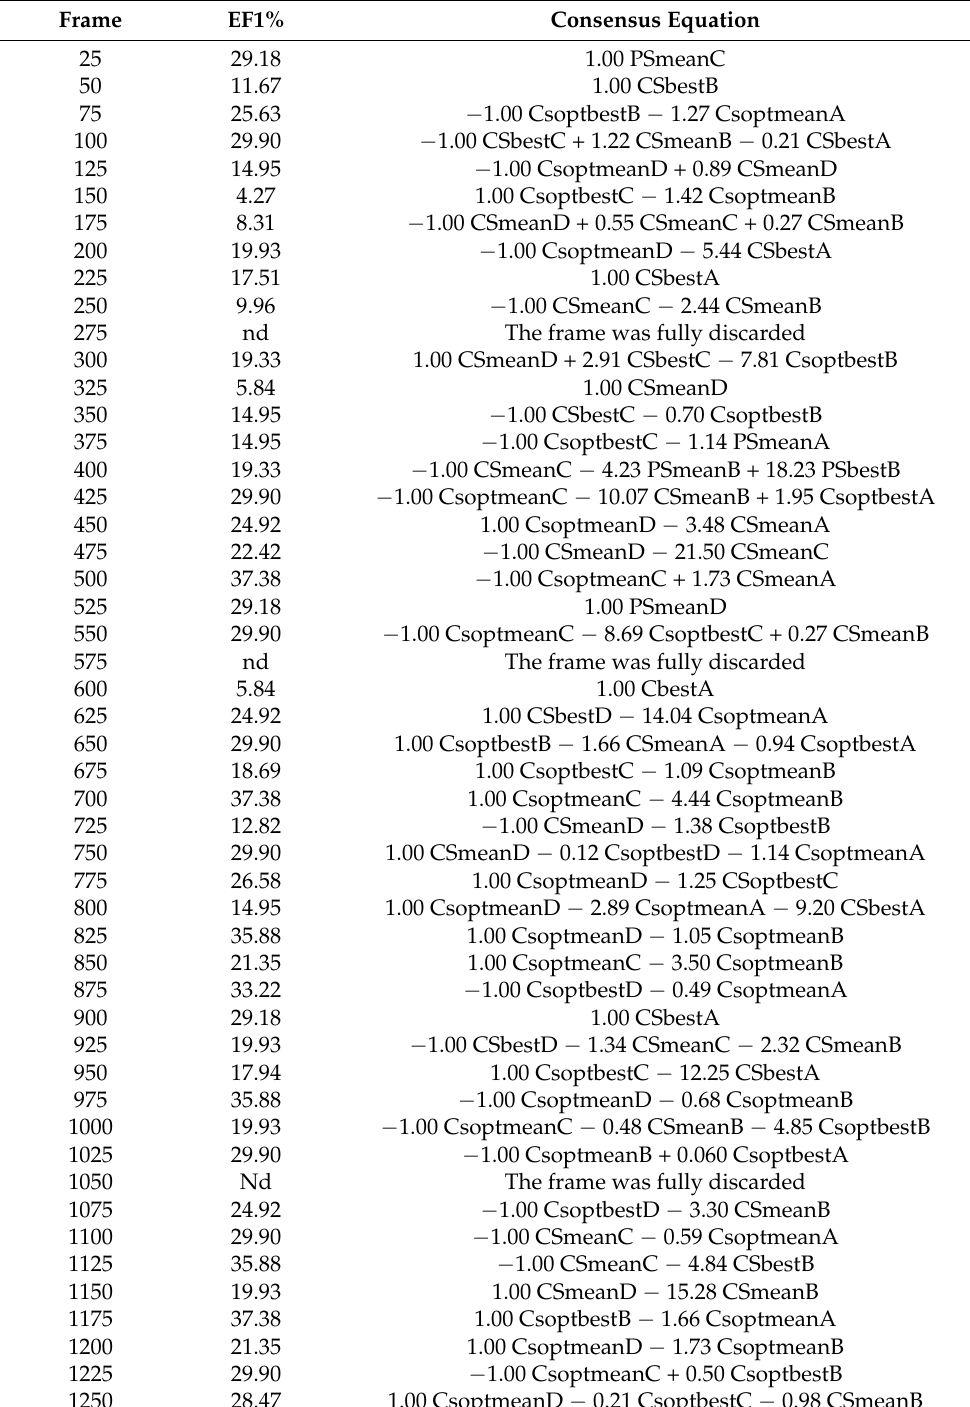
Table 3. Best predictive consensus models and relative EF1% values as obtained by the selected optimized